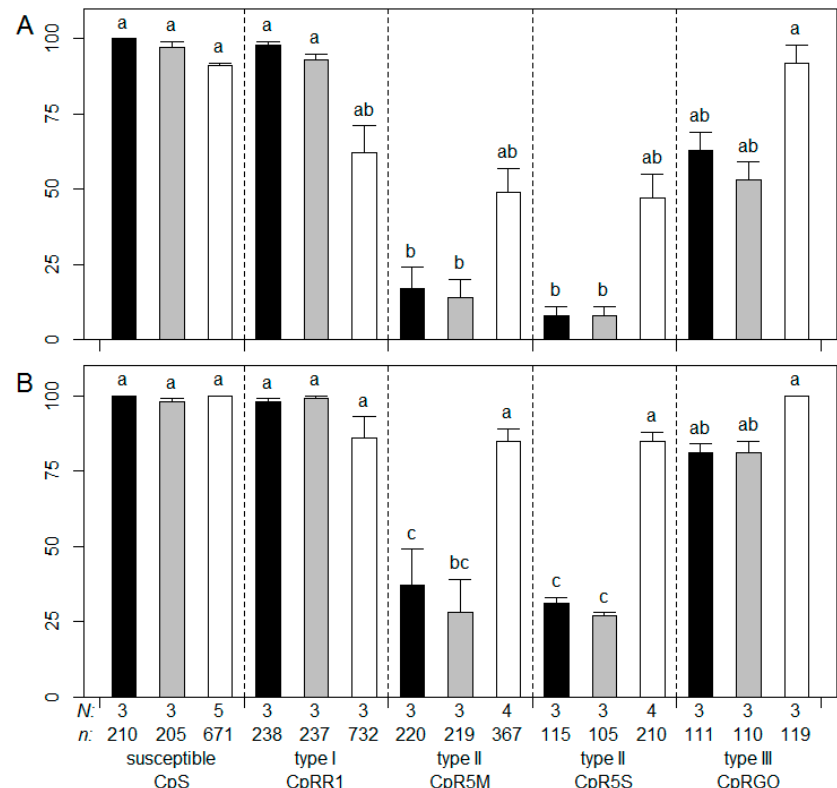
Figure 1. Resistance testing in different Cydia pomonella strains with novel Cydia pomonella granulovirus isolates. Mortality of neonates of CpS, CpRR1, CpR5M, CpR5S, and CpRGO (type I to III resistance) tested for resistance on artificial diet containing the commercial CpGV isolates 0006 (black bars), R5 (grey bars), or V15 (white bars) at the discriminating concentration of 5.8 × 10 4 occlusion bodies per mL. Abbott (1925) corrected mean mortality and standard error of mean (error bars) were determined at seven days ( A ) and 14 days ( B ) post infection. The total number of tested individuals ( n ) and independent replicates ( N ) are given below the chart. Columns marked by different letters differed significantly (analysis of variance (ANOVA), post-hoc Tukey´s Honestly Significant Differences test, p < 0.05).